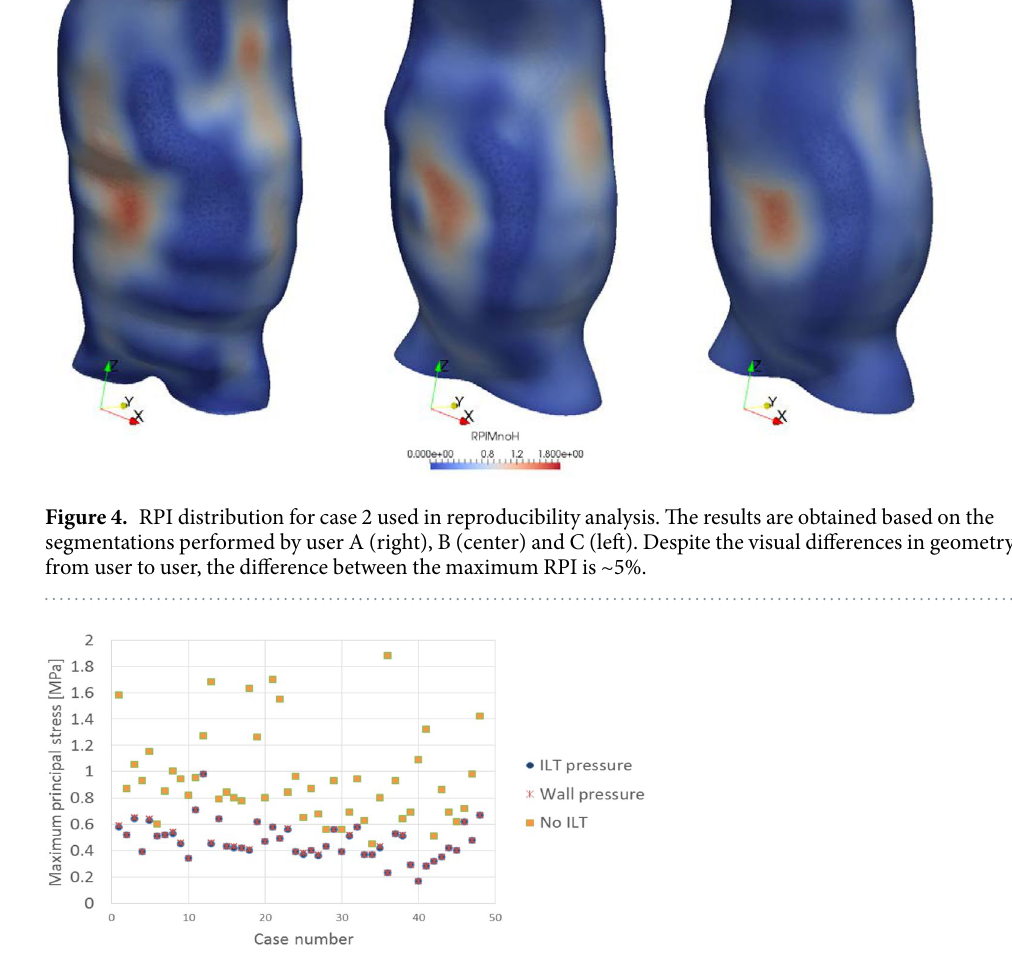
Figure 5. Influence of modelling scenario on the computed stress. Three scenarios are compared. There is little difference between the stresses computed using the “ILT pressure” and “Wall pressure” scenarios. The inclusion of ILT results in a significant reduction in the computed stress.